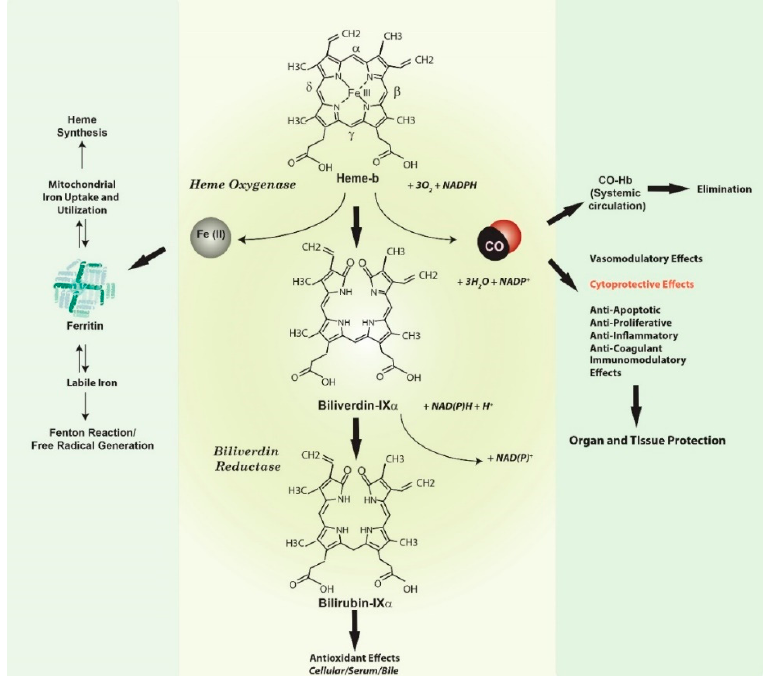
Figure 1. Heme oxygenase activity and end-product generation. Heme oxygenase (HO) is a metabolic enzyme that catalyzes the rate-limiting step in the oxidative catabolism of heme to generate the bile pigment biliverdin-IX α (BV) [1,2]. The HO reaction requires molecular oxygen (O 2 ) and reducing equivalents from NADPH cytochrome p-450 reductase. The HO reaction releases the α -methene